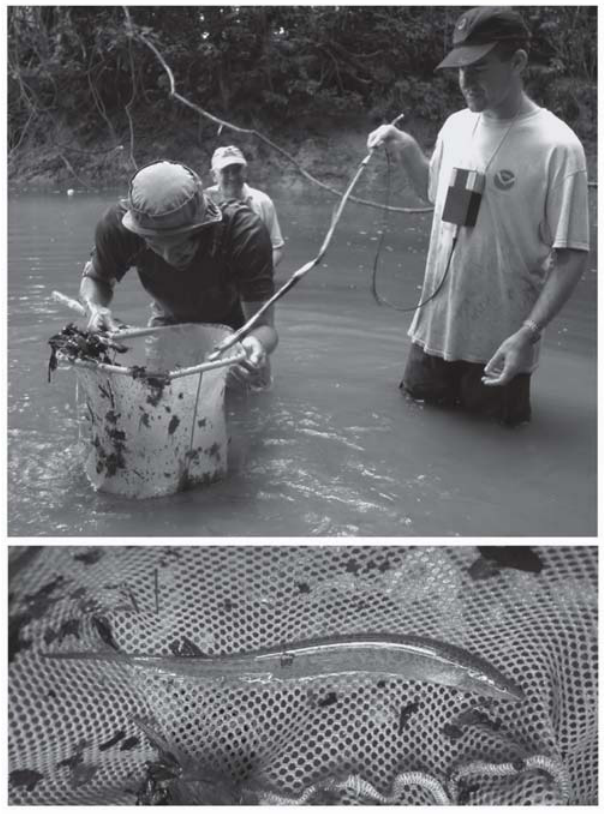
Fig. 4. Electric Fish Finder/dipole and dip net used in combi- nation to catch a juvenile Hypopomus artedi from a leaf litter bank in a rainforest stream, northern